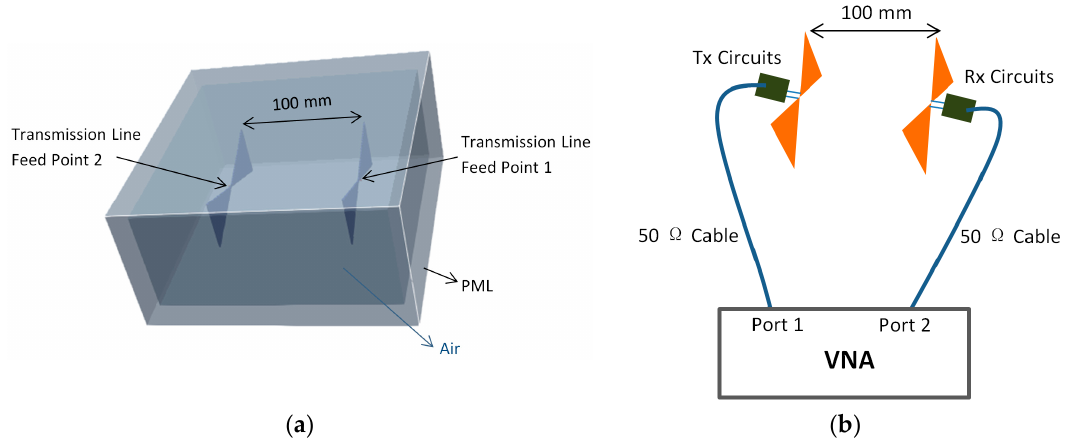
Figure 3. Setups for face-to-face experiments: ( a ) Simulation setup; ( b ) Measurement setup.